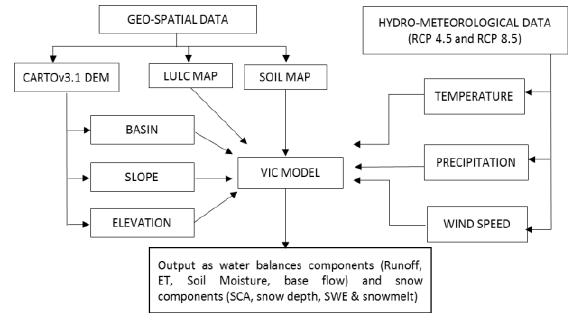
Figure 5: Flowchart of methodology used in the study